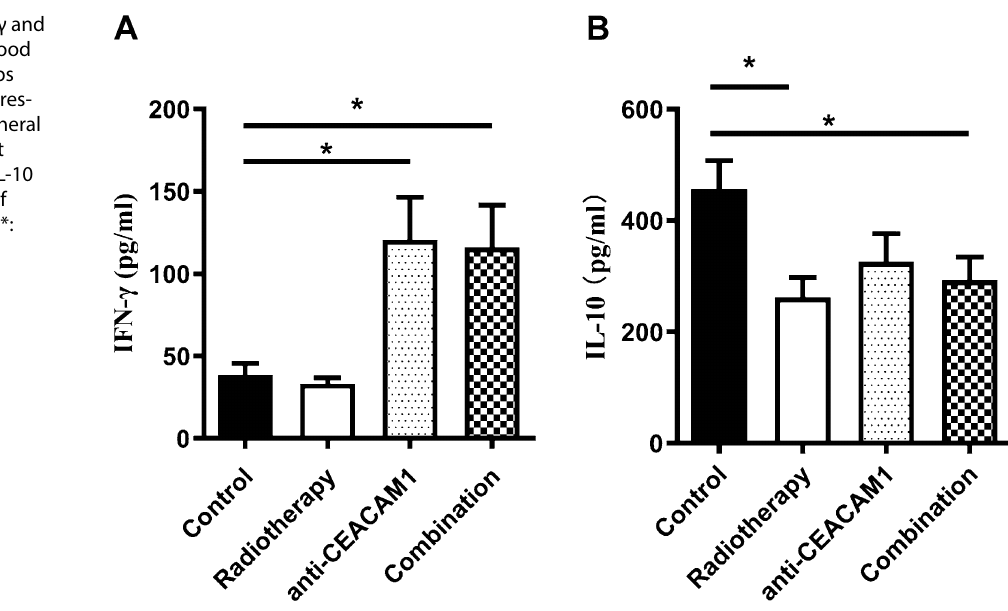
Fig. 5 Expression of IFN-γ and IL-10 in the peripheral blood of mice in different groups detected by ELISA. A Expres- sion of IFN-γ in the peripheral blood of mice in different groups. B Expression of IL-10 in the peripheral blood of mice in different groups. *: P < 0.05